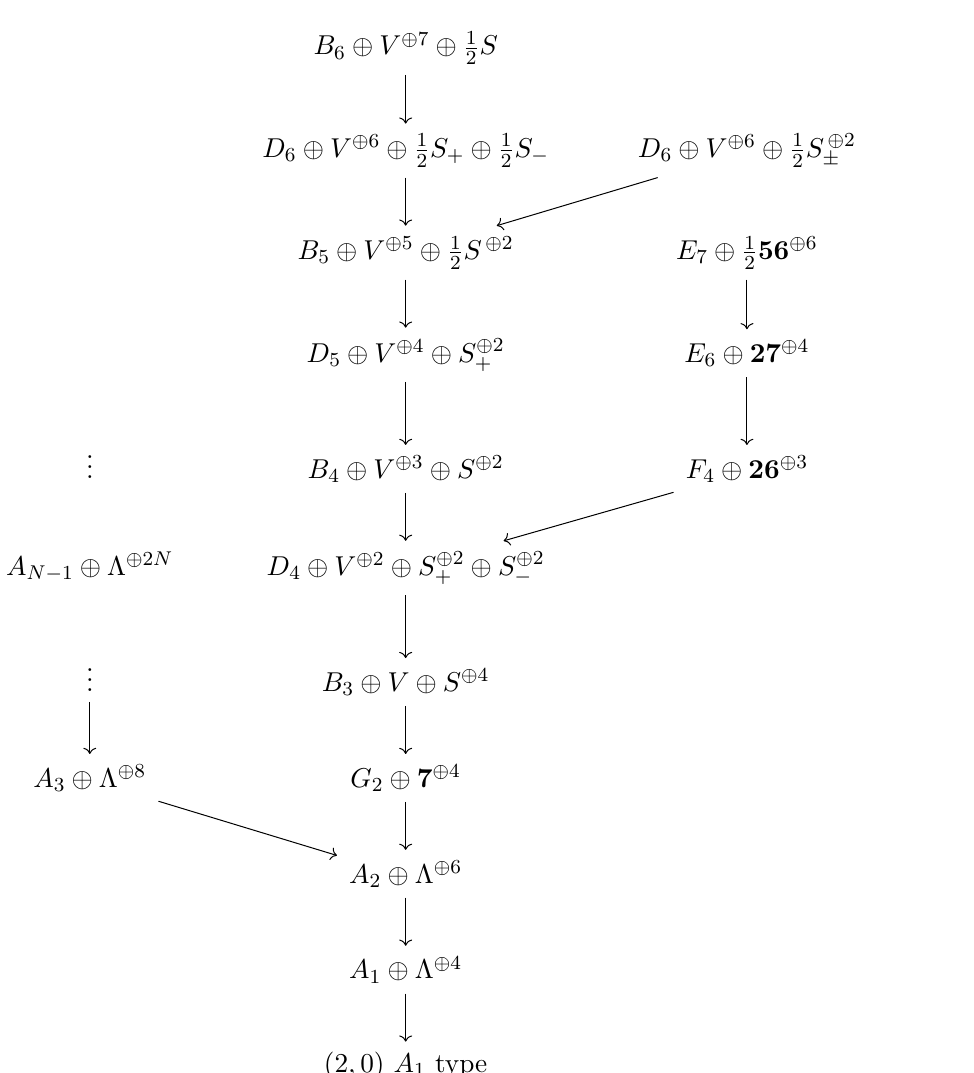
Figure 9 . Infinite length Higgsing tree over the base O ( − 2) → P 1 , with the M-string theory at its